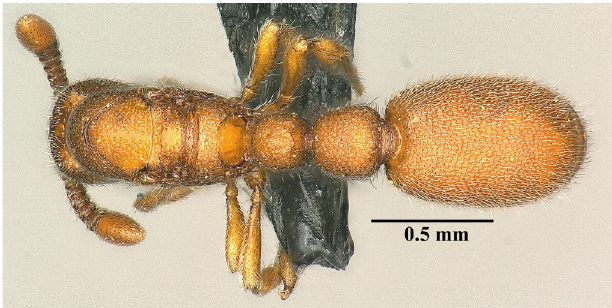
Fig 6 . Ooceraea octoantenna Zhou & Chen sp. nov, paratype queen, body in dorsal